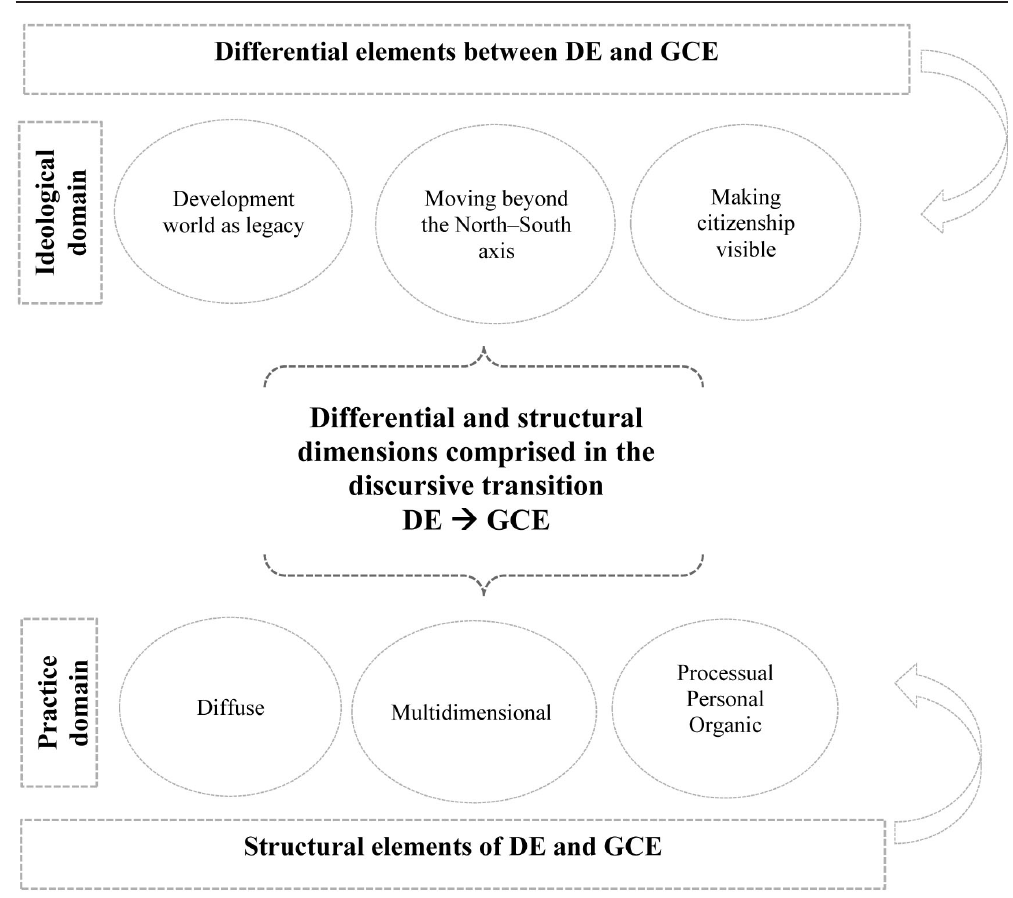
Figure 1: Discursive transition: differences and meanings beyond terms – thematic